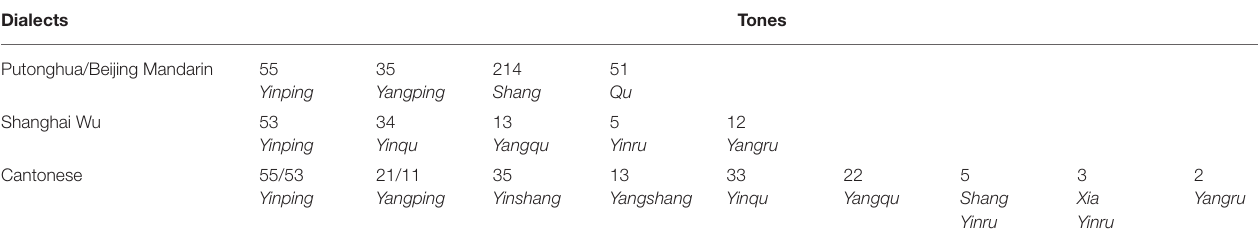
TABLE 1 | Tone systems of Beijing Mandarin, Shanghai Wu, and Guangzhou Cantonese (with tones’ traditional names in italic).